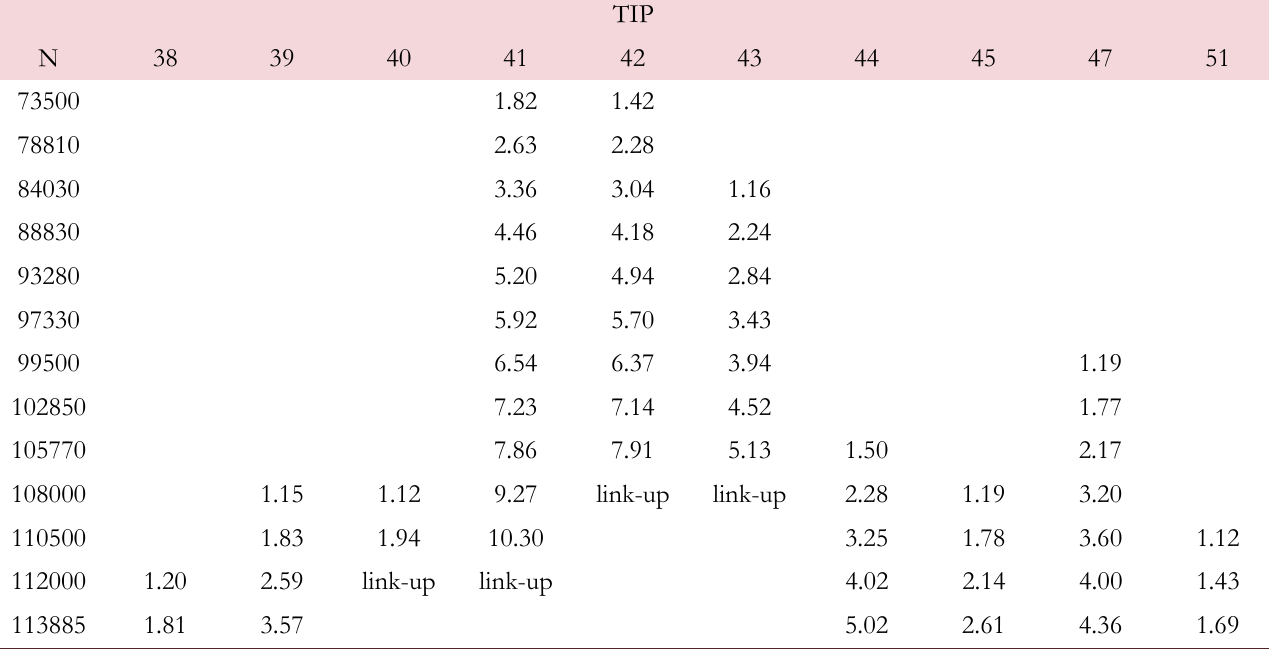
Table 1: Crack propagation lengths (mm) versus load cycles.